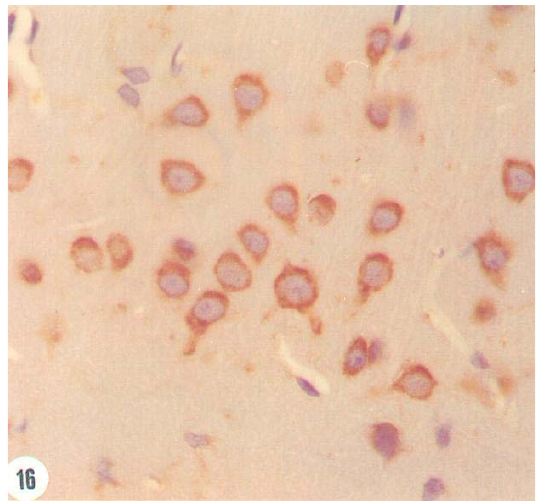
Figure 16. Increased Bcl-2 immunoexpression 24 hr after low dose envenoming.